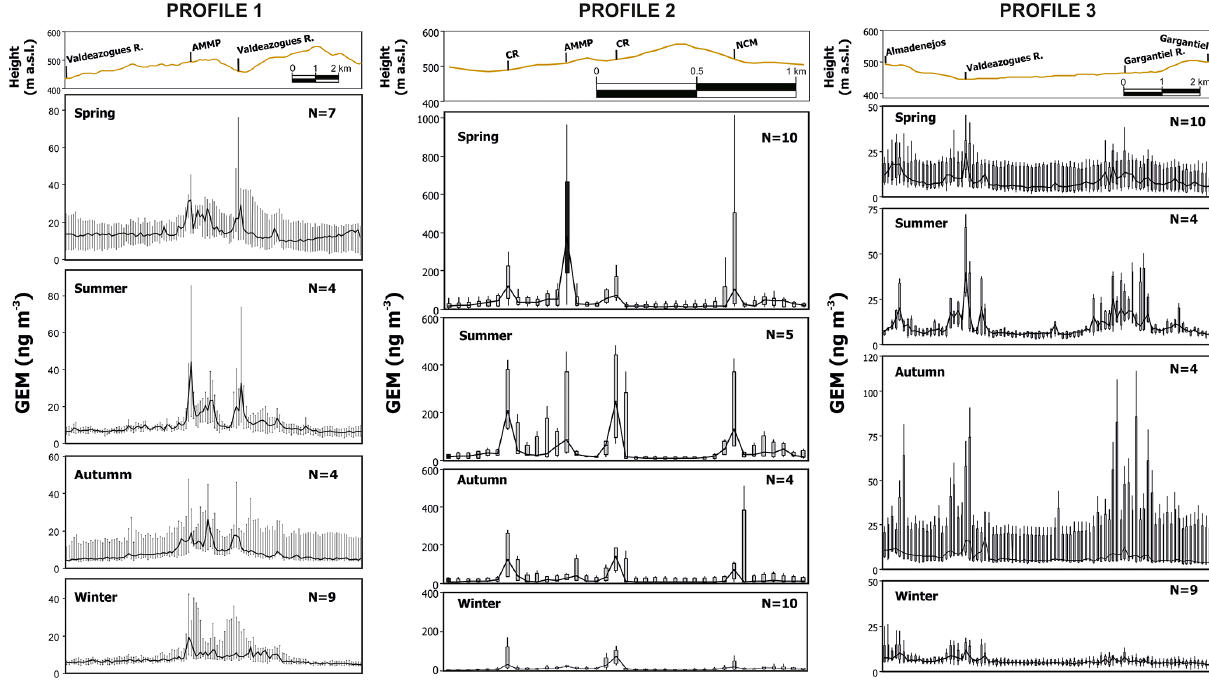
Figure 5. Box plot of GEM in the horizontal profiles along the Almadenejos area. Each box represents the average of 100m. The location of these profiles is shown in detail in Fig. 1.